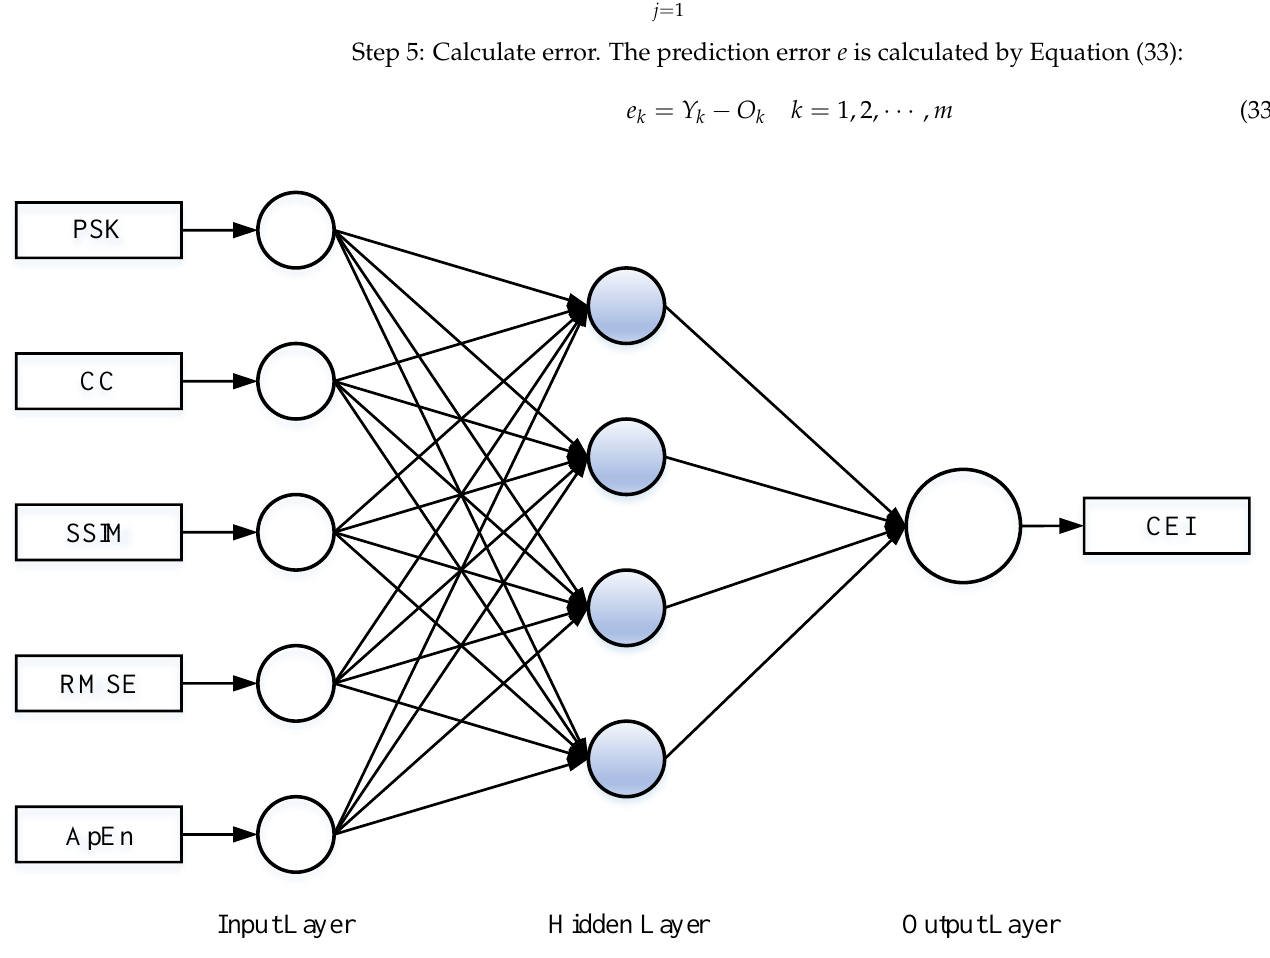
Figure 6. The topology diagram of BP neural network. There are 5 n = nodes in the input layer of the BP neural network, which are PSK, CC, SSIM, RMSE and ApEn. The hidden layer has 4 l = nodes, and the final output layer has only node, which is CEI. w , ij